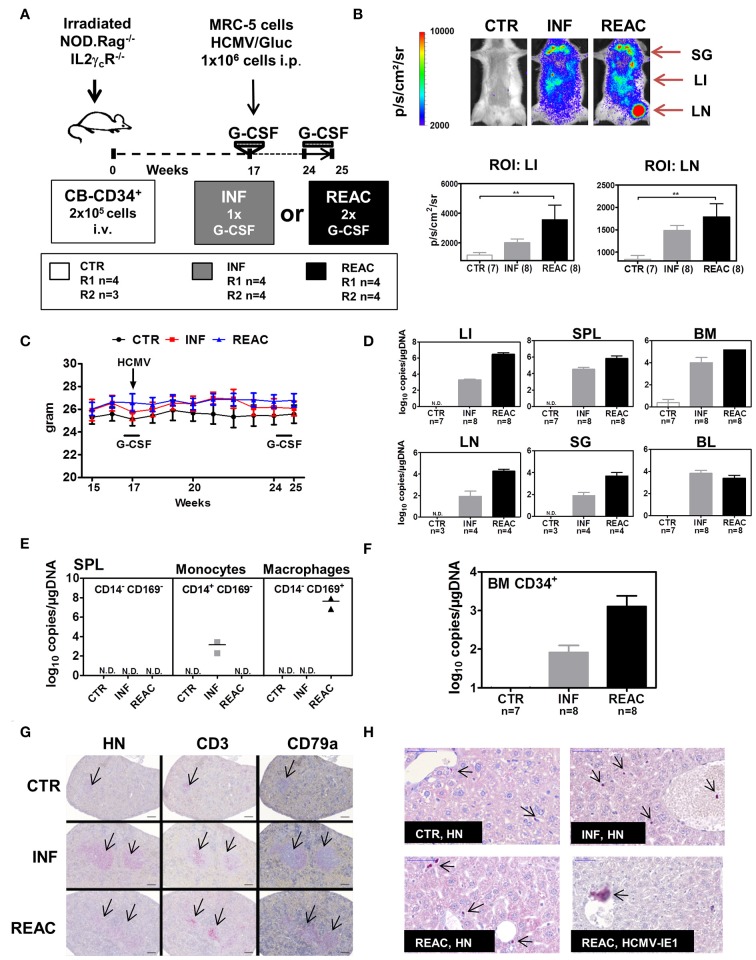
Infections of humanized mice with the HCMV/GLuc strain followed by reactivations stimulated by hG-CSF. (A) Schematic representation of experiments 3 and 4. CB-HSCT was performed for generation of control mice (CTR, n = 7) using 2.0 × 105 CD34+ cells injected i.v. into NRG mice. For the infection group (INF, n = 8) 1 × 106 MRC-5 cells infected with HCMV/GLuc were injected i.p. and received 150 ng hG-CSF administered s.c. for 5 days, at week 17. For the reactivation cohort, (REAC, n = 8), 2.5 μg hG-CSF were administered s.c. daily for 7 days after week 24. (B) Representative pictures obtained from optical imaging analysis for each group (scale bar depicts the average radiance as p/s/cm2/sr) and quantified data analyzed by applying the same region of interest (ROI) for each mouse. Statistical analyses were performed with one-way ANOVA (** < 0.01). (C) Weekly weight monitoring of mice for each cohort from week 15 to 25 after HSCT for CTR (black), INF (red) REAC (blue). (D) RT-q-PCR analysis for detection of HCMV DNA in LI, SPL, BM, LN, SG, and PBL depicted as log10 copies/μg DNA. Cohort sizes (n) analyzed for each tissue are shown and no detected (N.D.) HCMV DNA for CTR mice. (E) Cells from SPL of two mice per cohort were sorted for selection of CD14+CD169− monocytes, CD14−CD169+ macrophages, or the double negative CD14−CD169− fraction. HCMV DNA copies were detected by RT-q-PCR and results for each cohort are shown. (F) CD34+ cells were sorted from BM samples. HCMV DNA copies were detected by RT-q-PCR and results for each cohort are shown. (G) Immuno-histopathological analysis of spleen for detection of human cell nuclei (anti-HN), T cells (anti-CD3), and B cells (anti-CD79a). The arrows point to small follicles in representative CTR mouse and enlarged follicles for INF and REAC representative mice. (H) Immuno-histopathological analyses of LI. Arrows point to stained human cell nuclei (HN) for representative CTR, INF, and REAC mice. LI of a REAC mouse with an infected cell expressing HCMV-IE1. Size bars at upper left corners correspond to 50 μm.